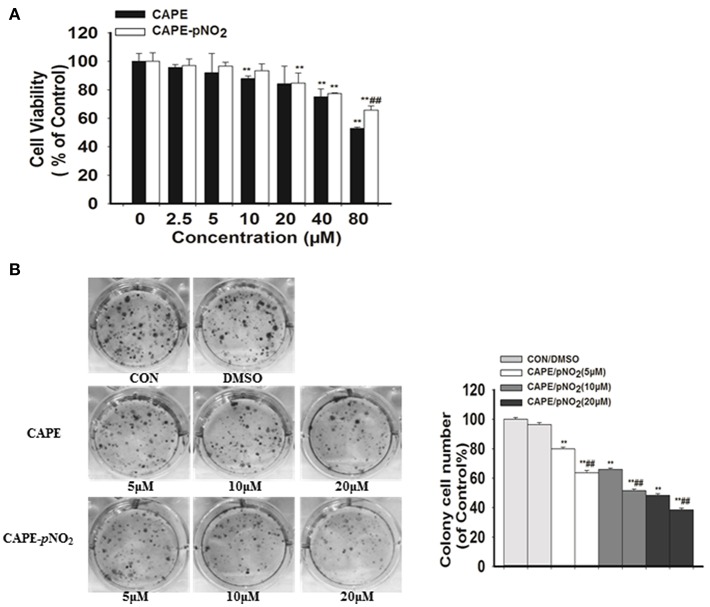
The effect of CAPE-pNO2 on inhibiting the viability and colony formation ability of MDA-MB-231 cells. (A) Cell viability was analyzed by an MTT assay, and cells were incubated with CAPE or CAPE-pNO2 (2.5–80 μM) for 24 h. (B) Colony formation ability was analyzed by a colony formation assay, and cells were incubated with CAPE or CAPE-pNO2 (5, 10, and 20 μM) for 24 h. Values represent the mean ± SD from three independent experiments; *p <0.05, **p<0.01: DMSO, CAPE and CAPE-pNO2 compared with the control; #p<0.05, ##p<0.01: CAPE-pNO2 compared with CAPE at the same concentration.